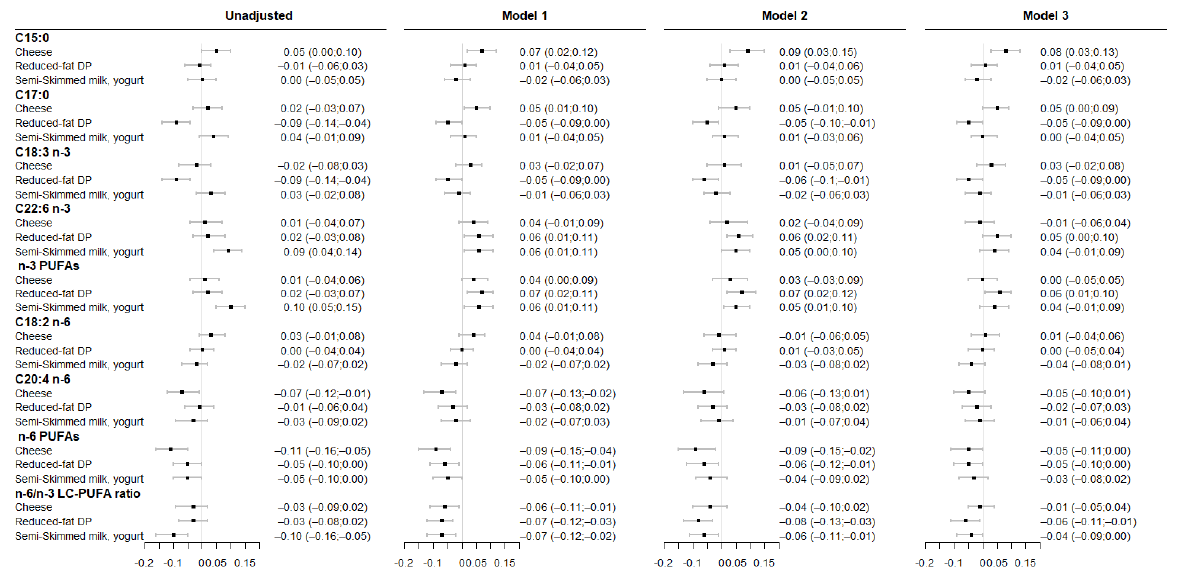
Figure 3. Associations between maternal DP patterns and fatty acid levels in cord RBC membrane. Results are from linear regression models ( β (95%CI)). Model 1 was adjusted for study center and maternal age at delivery. Model 2 was adjusted for model 1 covariates and for maternal “healthy” dietary pattern during pregnancy. Model 3 was adjusted for model 1 covariates and for the frequency of fish consumption during pregnancy. All DP patterns were studied simultaneously within each model.